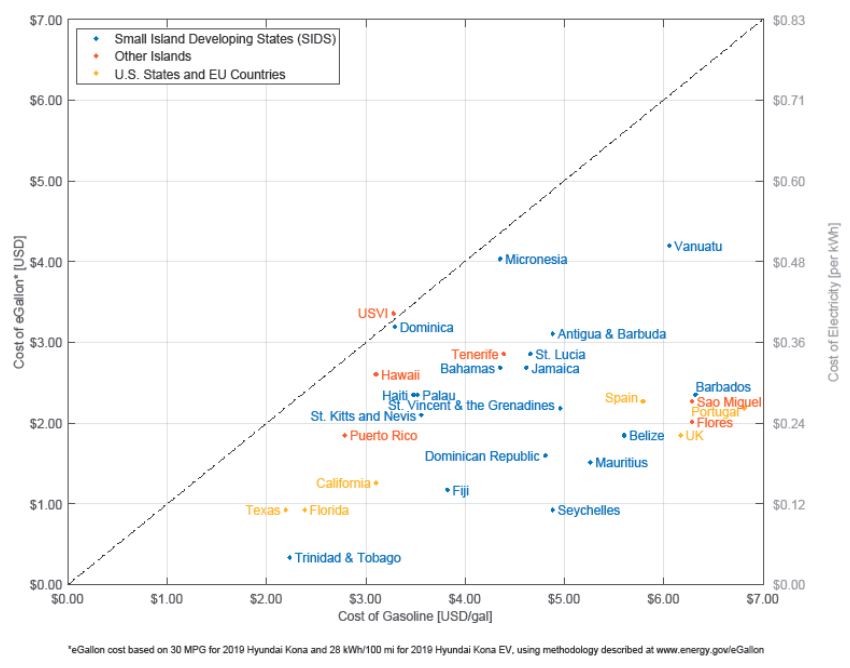
Figure 1. Cost of a gallon of gasoline versus an EV “eGallon” (most data from [6,7]). Yet, in the smaller electric grids of remote and island areas, relatively modest amounts of EVs can result in significant increases in total electric load, which could pose challenges to grid operations. Technical obstacles include grid reliability issues, increased